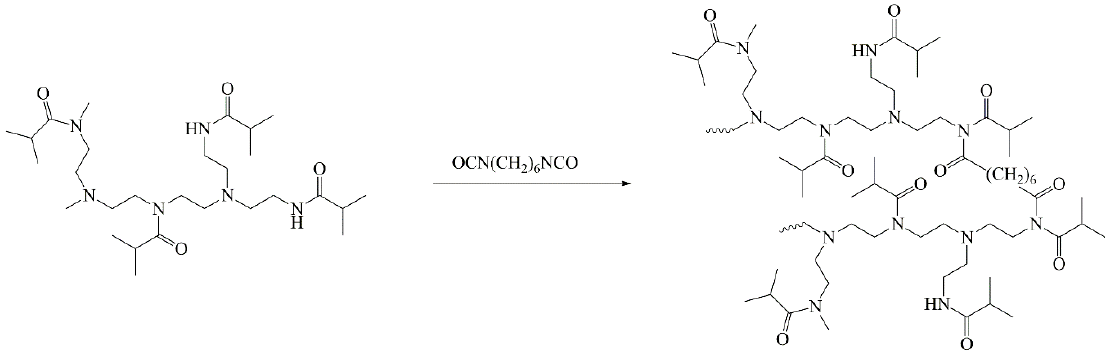
Figure 1. Scheme of synthesis of polyethyleneimines (PEI)-n. Table 1. Molar masses, structure, and hydrodynamic characteristics of PEI-n.